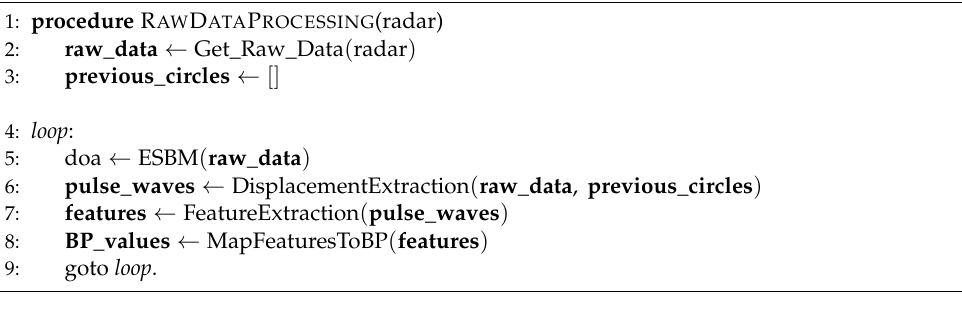
Algorithm 1 Pseudocode for raw data processing